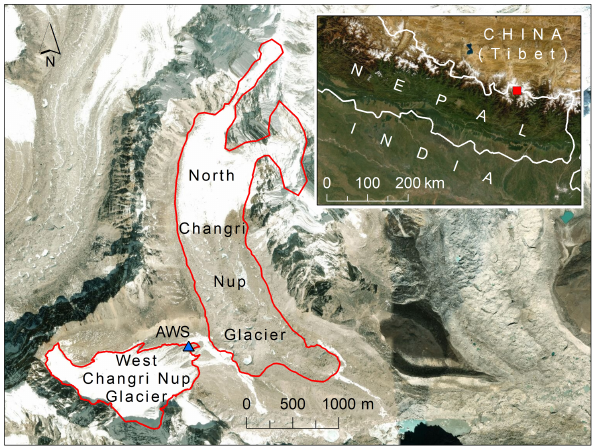
Figure 1. A map of West Changri Nup and North Changri Nup glaciers, showing the location of the AWS (Sect. 2.2), which is also the location of the measurements of debris temperature and point mass balance. Source: Esri, DigitalGlobe, GeoEye, Earthstar Geo- graphics, CNES/Airbus DS, USDA, USGS, AeroGRID, IGN, and the GIS user community. The glacier outlines are from Sherpa et al.